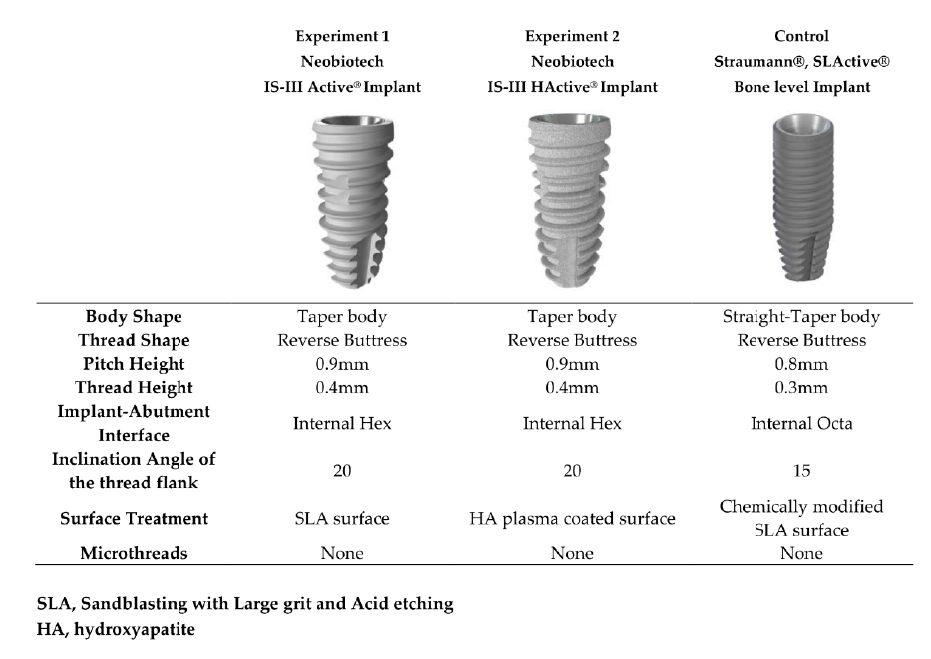
Figure 1. Characteristics of the implant systems used in this study: CMI IS-III active (Neobiotech, Seoul, Republic of Korea), CMI IS-III Hactive (Neobiotech, Seoul, Korea), and SLActive bone